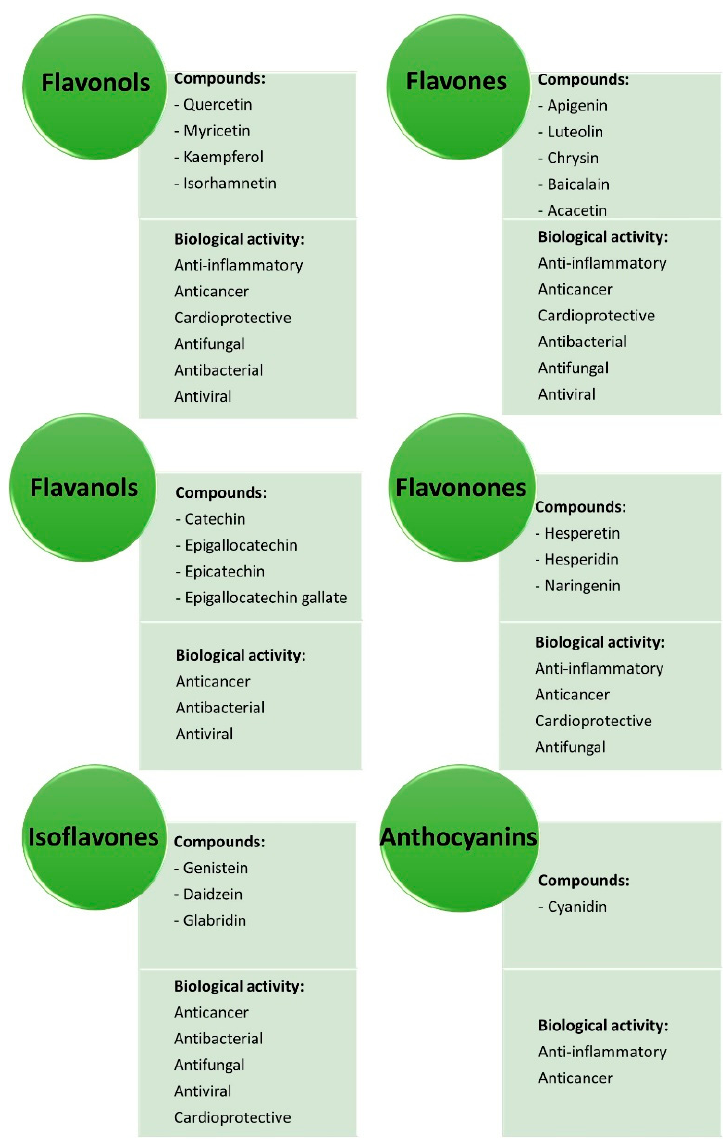
Figure 8. Flavonoid classes and some examples of their biological